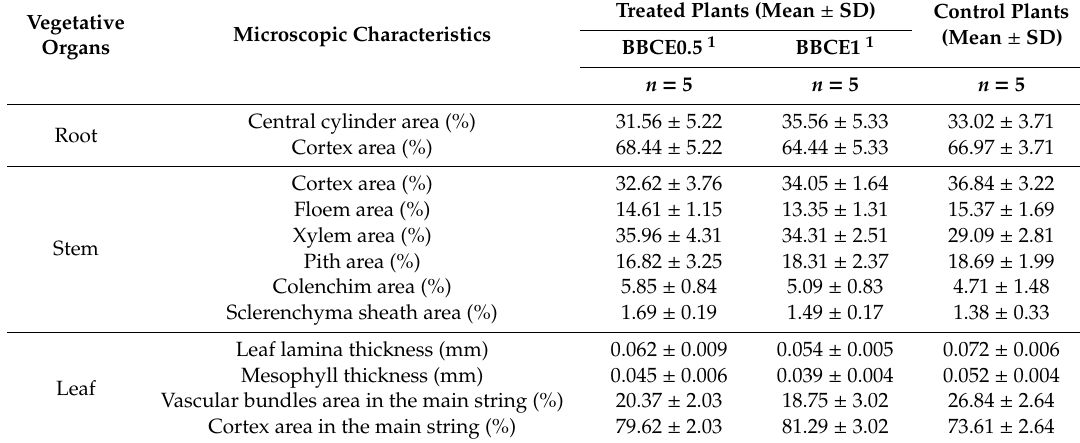
Table 3. The microscopic characteristics of vegetative organs in case of treated and control sage plants. Vegetative